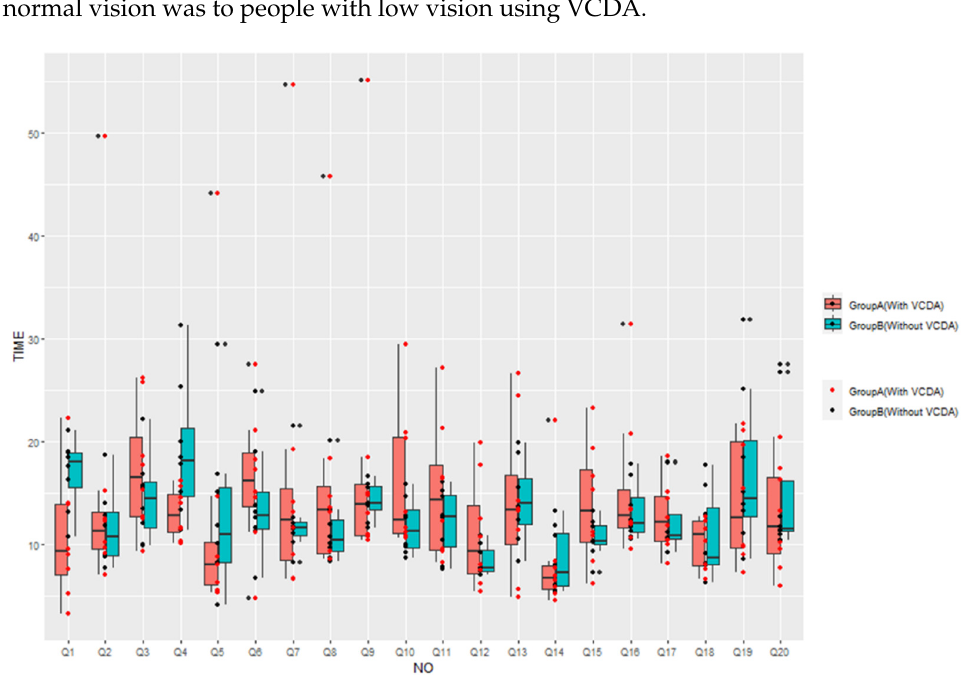
Figure 4. Comparison of information recognition speed between Group A (with VCDA) and Group B (without VCDA).